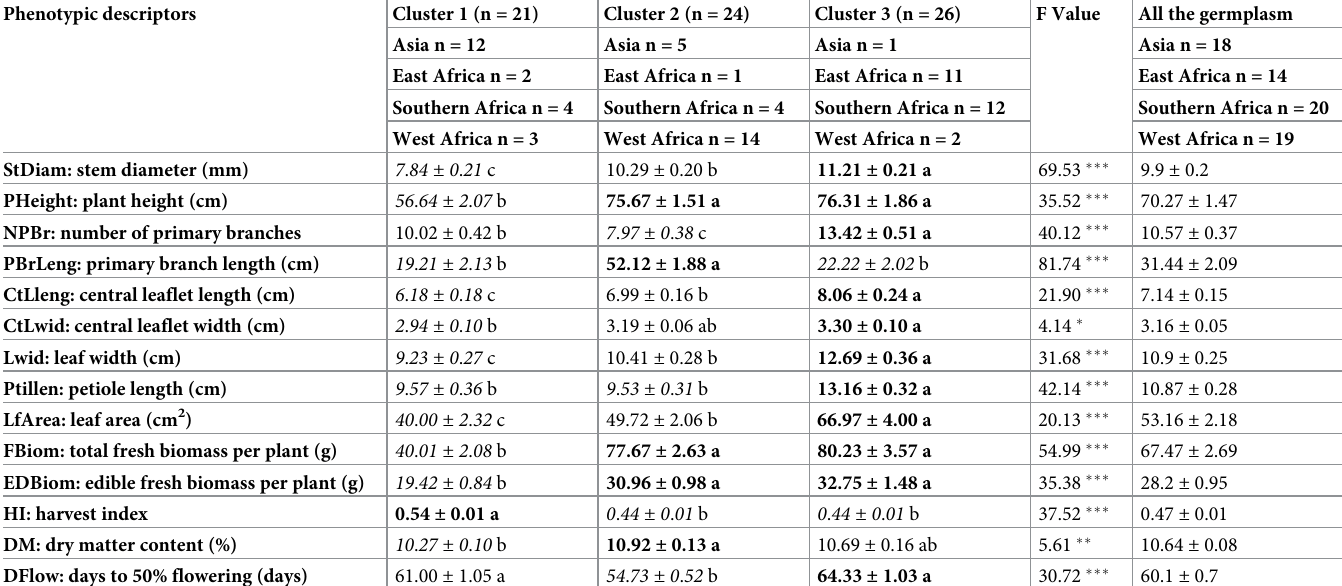
Table 5. Phenotypic descriptors of Gynandropsis gynandra ’s